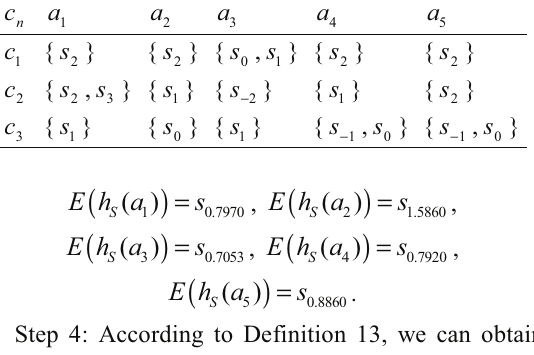
Table 5. Decision matrix provided by